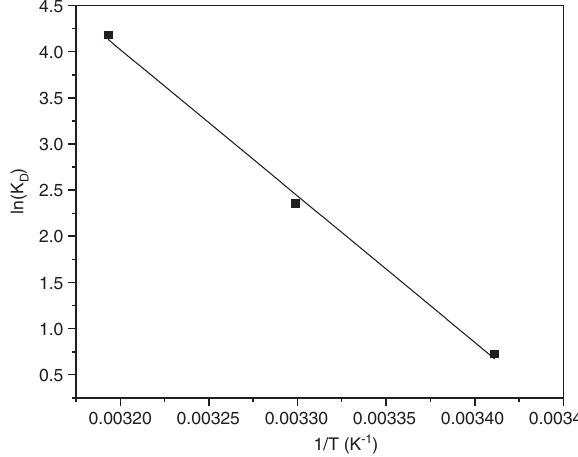
Figure 10 Van’t Hoff equation plot for the adsorption of Cr(VI) on